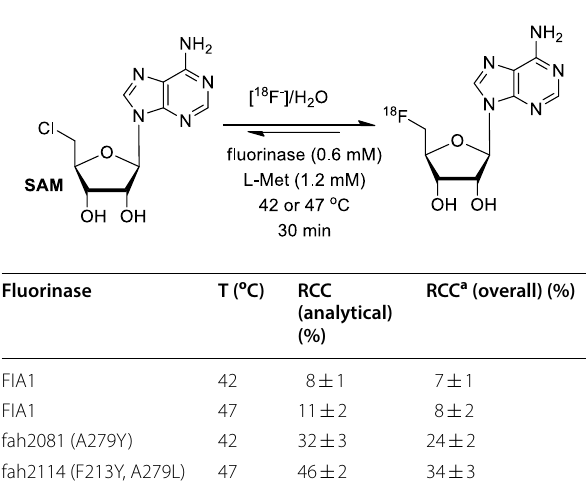
Table 2 Fluorinase variants obtained by directed evolution